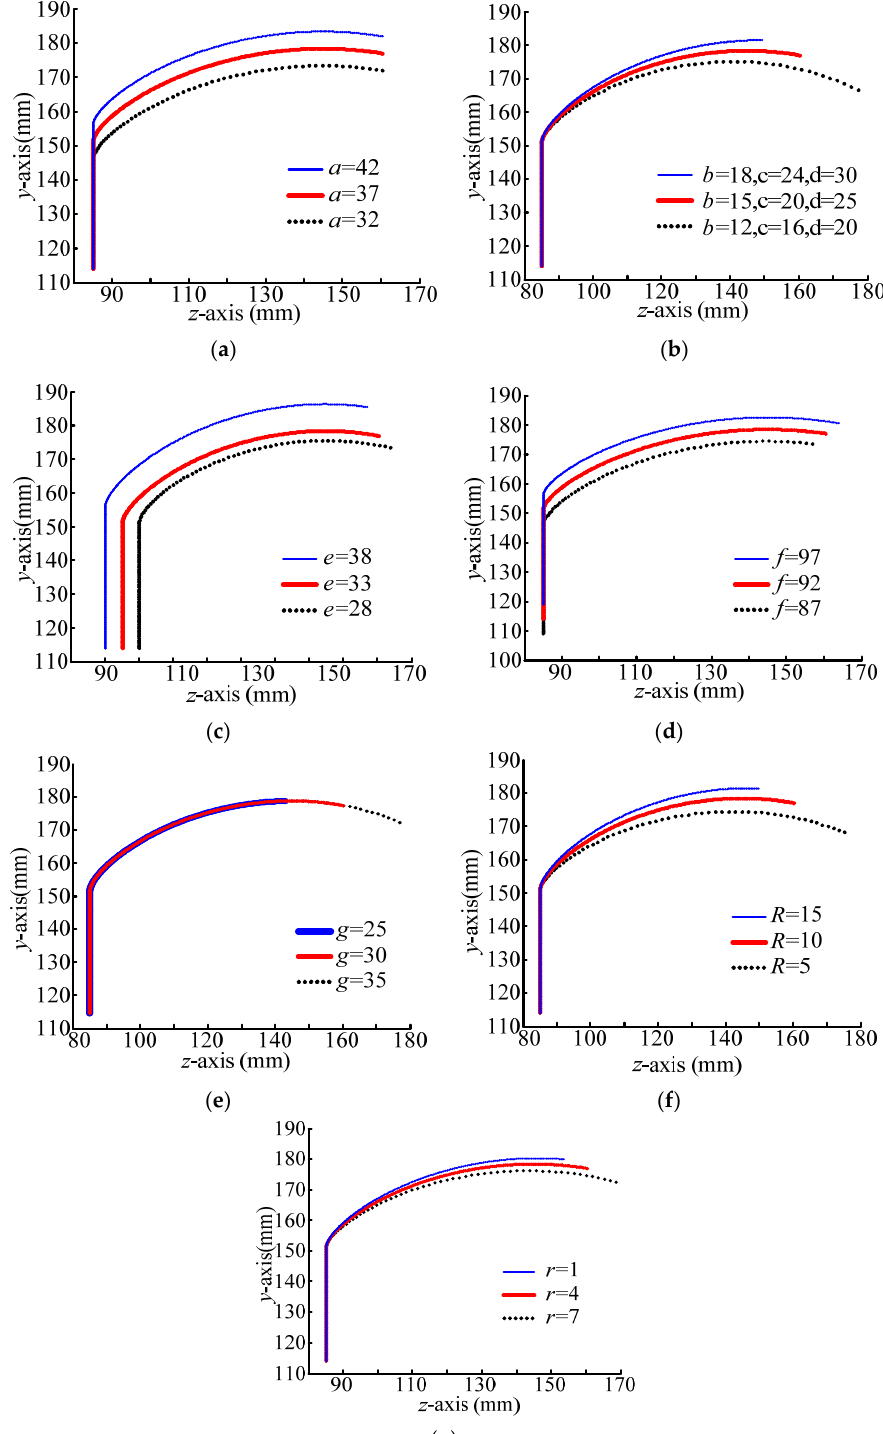
Figure 17. Schematic diagram of the analysis of the influence of the trajectory parameters on the capture hook vertex. ( a ) Analysis of parameter a ; ( b ) analysis of parameters b , c , d ; ( c ) analysis of parameter e ; ( d ) analysis of parameter f ; ( e ) analysis of parameter g ; ( f )analysis of parameter R ; ( g ) analysis of parameter r . was determined: Parameter a affects the length of the straight-line segment of the trajec- tory curve, where the larger the value, the longer the straight-line segment. Parameters b , c , and d form three sides of a right-angled triangle, so the larger the values, the smaller the curvature and the shorter the length of the curve segment. Parameter e affects the position of the z-axis direction of the trajectory curve, so the larger the value, the closer the curve is to the negative direction of the z -axis. Parameter f affects the position of the y -axis di- rection of the trajectory curve, so as this value increases, the curve moves closer to the positive y -axis. Parameter g affects the length of the curved segment of the trajectory curve, so the larger the value, the longer the length of the curved segment. Parameter R affects the curvature and length of the curved segment of the trajectory curve, so as this